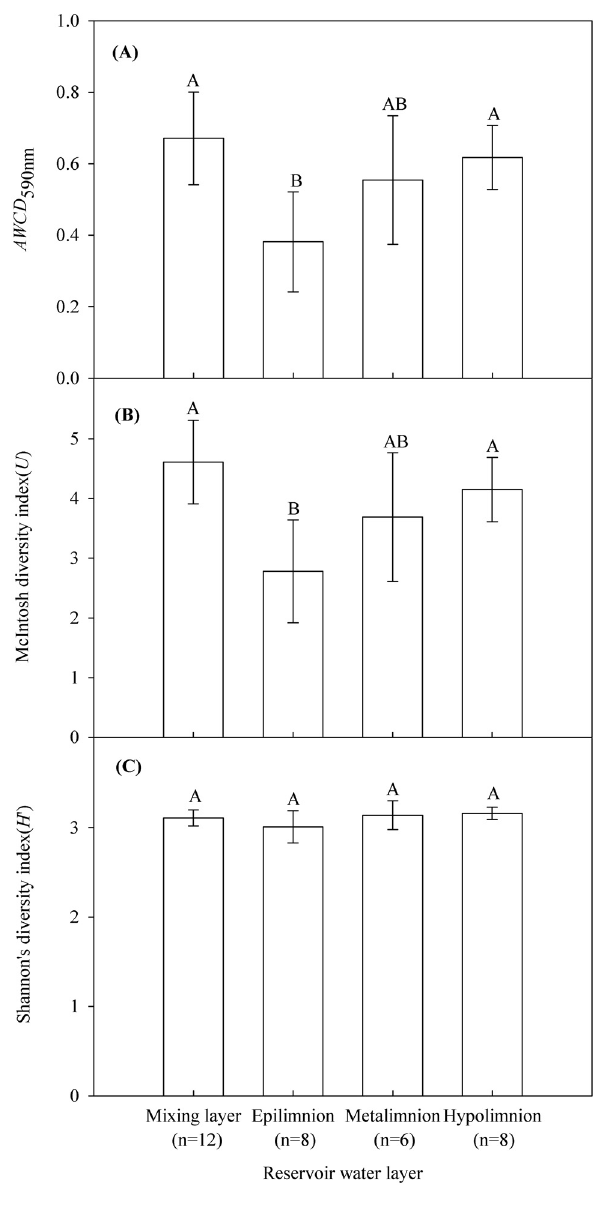
Figure 3. Functional diverstity indices of bacterial communities. ( A ) Average well color development ( AWCD 590nm ); ( B ) McIntosh diversity ( U ) and ( C ) Shannon diversity ( H ') at